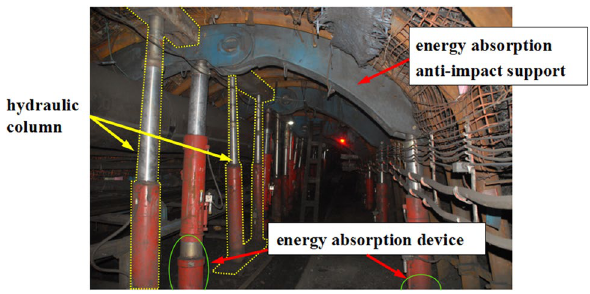
Figure 1. Photograph of energy absorption anti-impact support in the